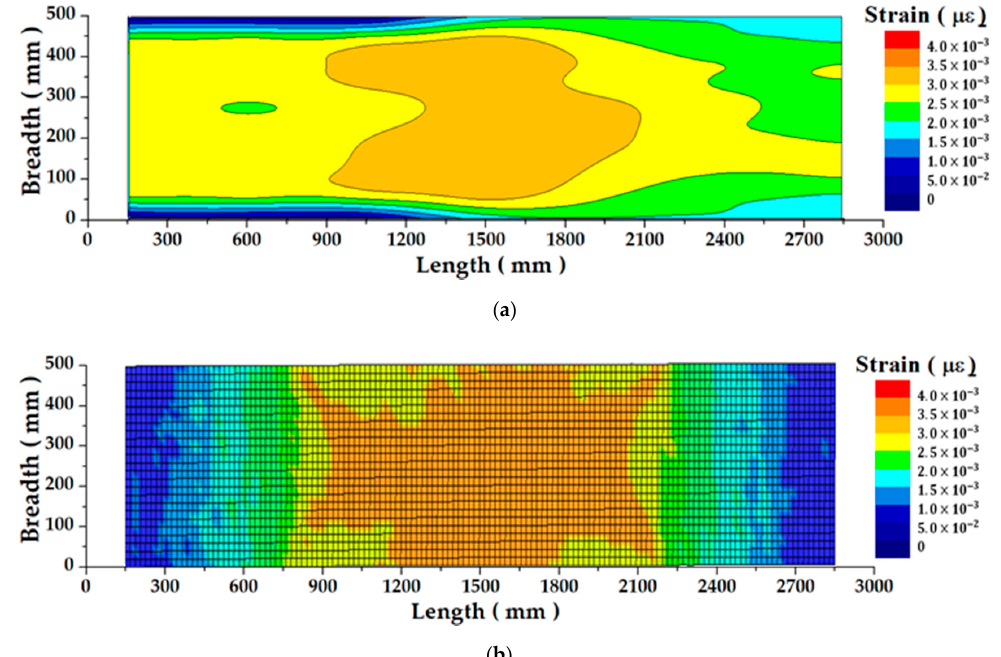
Figure 10. Comparison of CFRP strain distributions using BOTDR sensor and analysis (M-50). ( a ) BOTDR, ( b ) FEM.